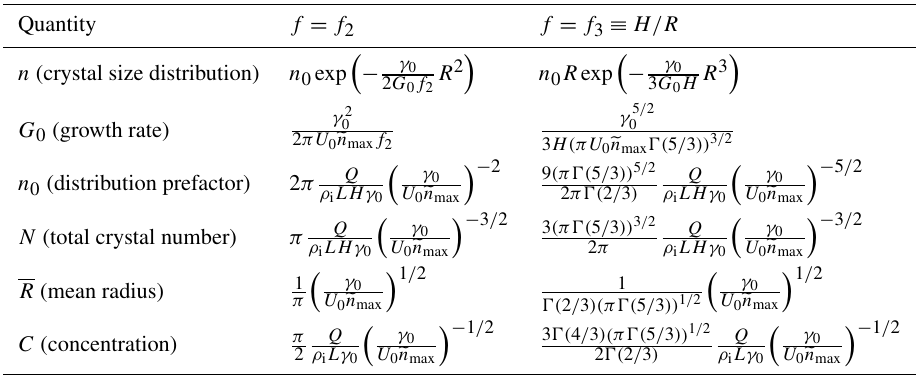
Table 1. Steady-state crystal size distribution results for two growth laws. Note that (cid:48)() here denotes the Gamma function. The steady-state supercooling can be computed using (cid:49)T = G 0 ρ i LH/( Nu k l )